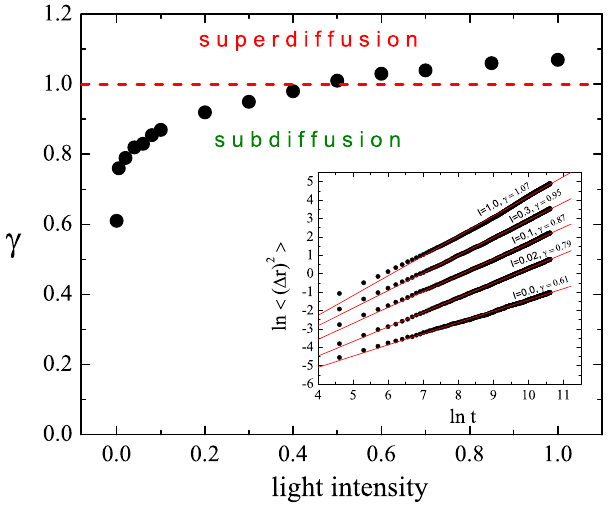
Figure 3. Plot of exponent γ (Equation (2)) as function of the reduced light intensity I 0 , calculated from the plots of ln (cid:104) ( ∆ r ) 2 (cid:105) against ln t (Inset). Constant illumination. Error bars are of a size of graphical symbols.